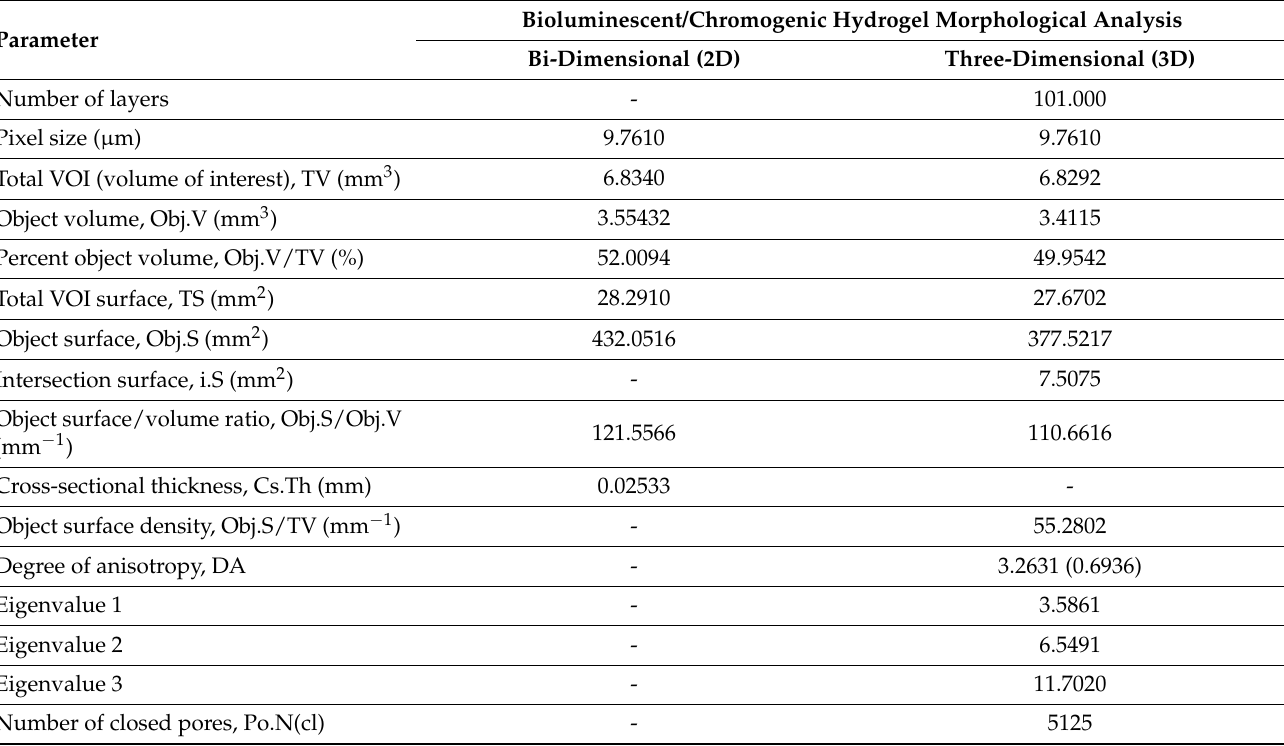
Table 2. Results obtained from the X-ray tomographic analyses performed to the bioluminescent/chromogenic hydrogel.